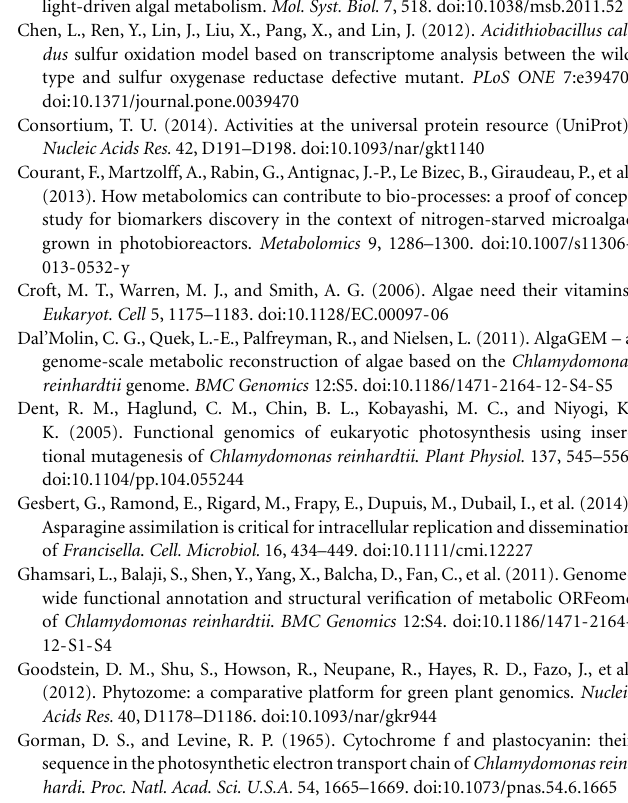
Table S1 | PM assays for PM01 to PM04 and PM06 to PM08, positive assays are shaded with yellow . Table S2 |A table of new metabolites that were added to generate iBD1106 along with their genetic annotations . Table S3 | Shadow prices for metabolites of iRC1080 and iBD1106 when biomass was set as objective function under growth with light and no acetate . Table S4 | Shadow prices for metabolites of iRC1080 and iBD1106 when biomass was set as objective function with growth under dark with acetate . Table S5 | Shadow prices for new metabolites in iBD1106 when Biomass was set as the objective function (growth under light without acetate and under dark with acetate) .